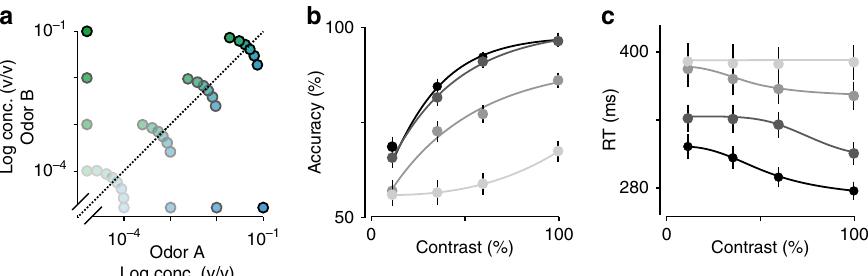
Fig. 4 Odor mixture identi fi cation task. a Stimulus design. Two odorants ( S -( + )-2-octanol and R -( − )-2-octanol) were presented at different concentrations and in different ratios as indicated by dot positions. In each session, four different mixture pairs (i.e. a mixture of speci fi c ratio and concentration and its complementary ratio) were pseudo-randomly selected from the total set of 16 mixture pairs and presented in an interleaved fashion. b , c Mean accuracy ( b ) and mean of reaction times ( c ) plotted as a function of mixture contrast. Each point represents a single mixture ratio. Error bars are mean ± SEM over trials and rats. Solid lines depict the obtained fi ts for the predicted curves of a DDM for each set of mixtures at a particular concentration, family functions as described in ref. 2 . Colors represent the total concentration of the mixture, with black indicating a 10 − 1 mixture and lightest gray 10 −